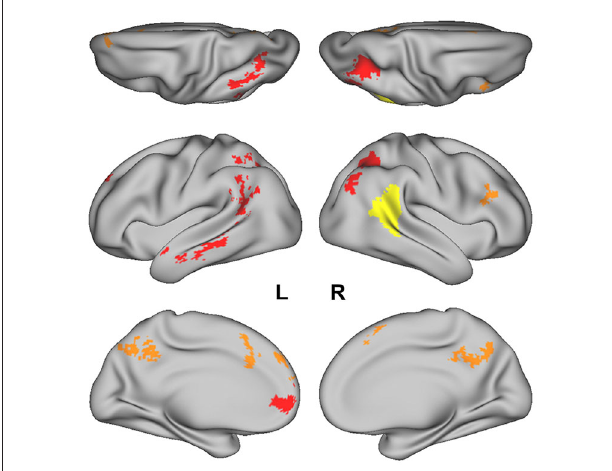
FIGURE 2 | The posterior superior temporal sulcus (pSTS) region-of- interest (ROI) obtained from the Atlas of Social Perception (Engell and McCarthy, 2013) for the ROI-based MVPA is displayed in yellow. Clusters of searchlight centers with significant four-way classification of the “Preference” trials in the whole-brain searchlight analysis are displayed in red and orange. Regions in red (i.e., L IPL/IPS, R IPS, amPFC, L MTG, and L ATL) had confusion matrices in which the diagonal elements had the highest numerical value in each